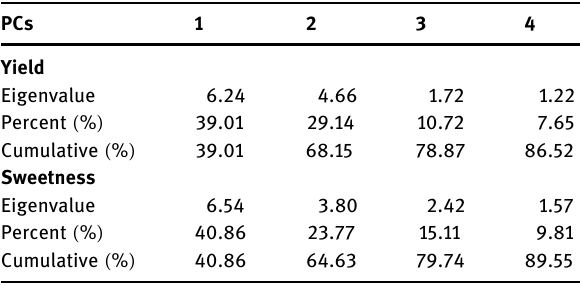
Figure 3: Dendrogram of storage root yield character on 16 honey sweet potato genotype based on stability ranks.